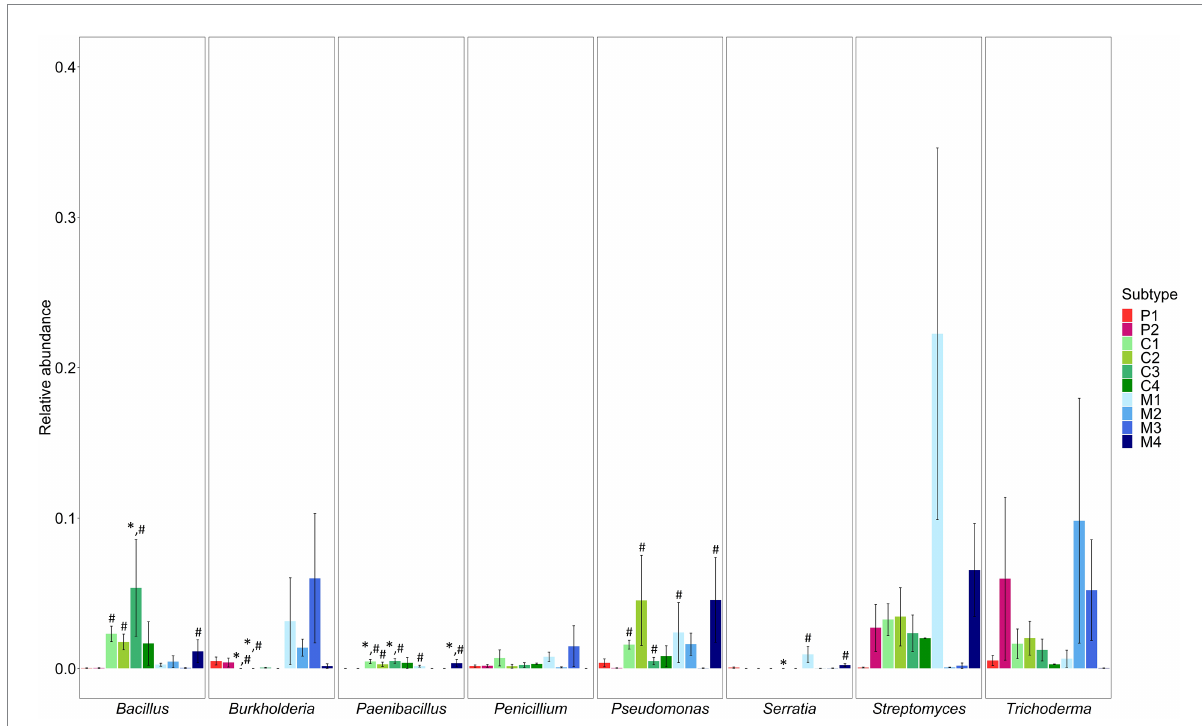
FIGURE 3 Mean relative abundances (proportions) ± SE of genera known to include beneficial microorganisms Bacillus , Burkholderia , Paenibacillus , Pseudomonas , Serratia, Streptomyces , Penicillium and Trichoderma in the different subtypes of peat-based substrates, composts, and management residues. Colors represent the different subtypes in each type of biomass. P1 = pure peat-based substrates ( n = 5); P2 = limed peat- based substrates ( n = 5); C1 = green composts ( n = 7); C2 = VFG composts ( n = 3); C3 = woody composts ( n = 4); C4 = peat composts ( n = 2); M1 = grass clippings ( n = 4); M2 = chopped heath ( n = 4); M3 = forest sods ( n = 2); M4 = woody fractions of composts ( n = 2). Asterisk indicates a significant difference as compared to P1. Hashtag indicates a significant difference as compared to